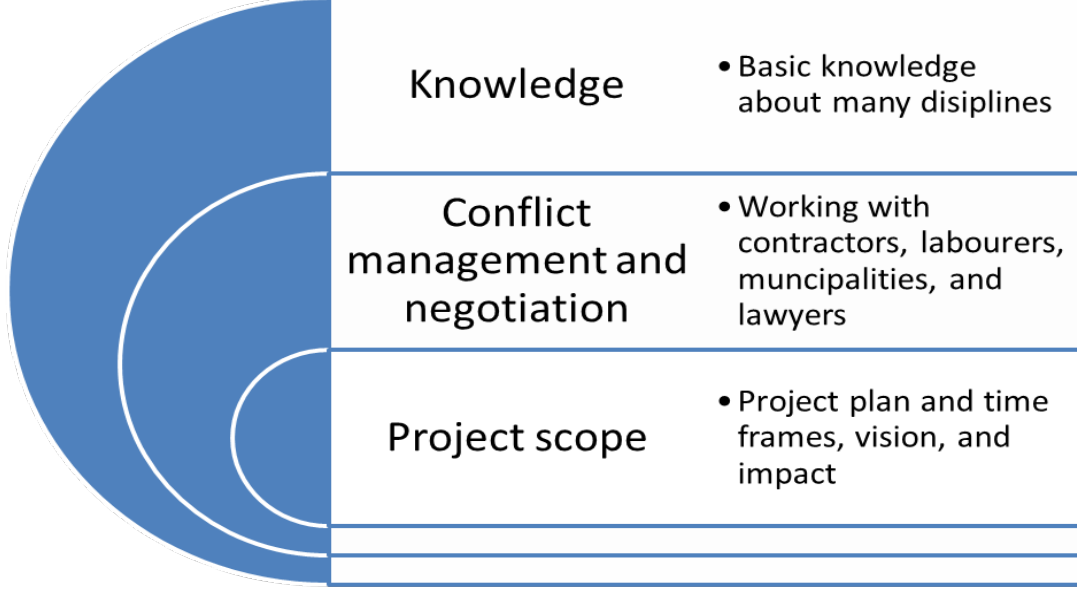
Figure 1 . Suggested curriculum for a human settlements